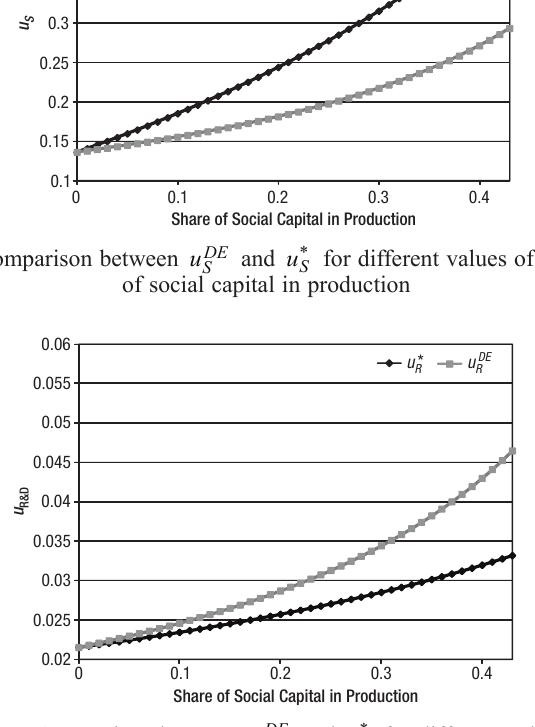
u and * u for different values R R